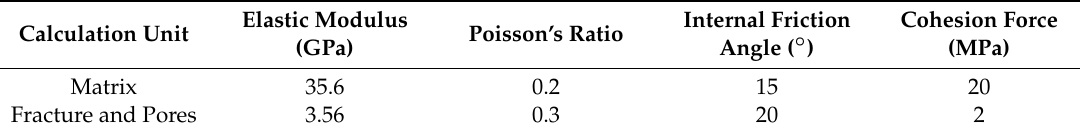
Table 3. The main input parameters for FEM simulation.